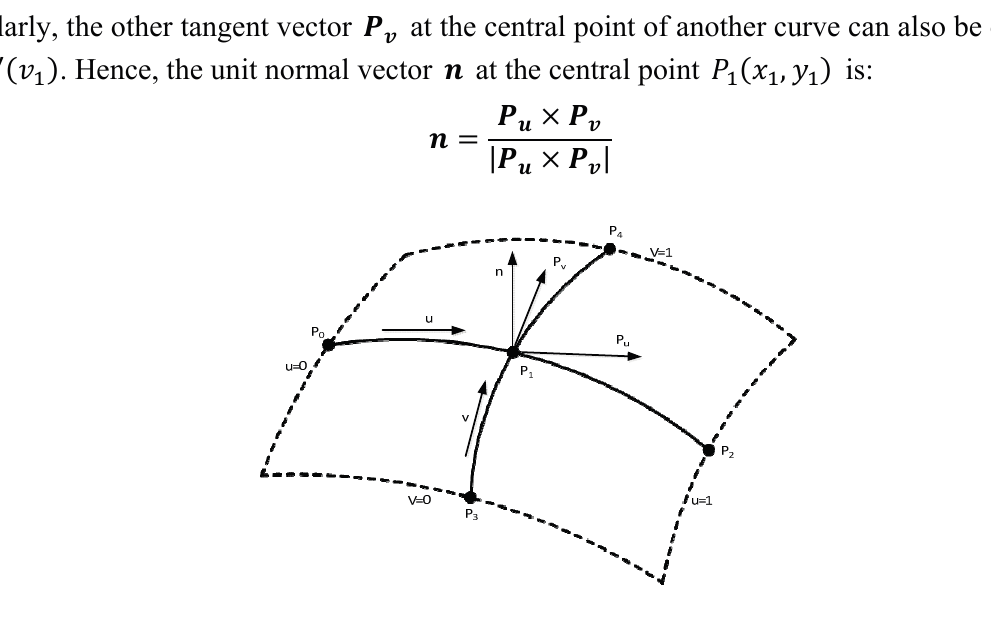
Figure 13. Quadratic Bezier curves intersect.